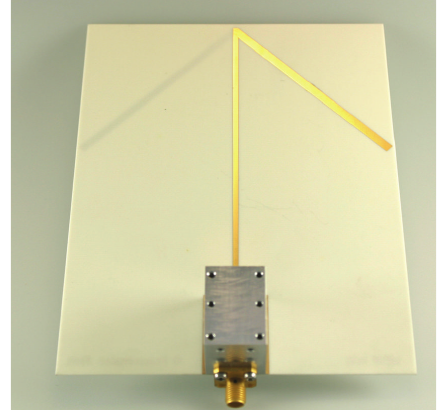
Figure 3: Antenna element prototype with flared dipole arms printed on PCB with coaxial connector attached.